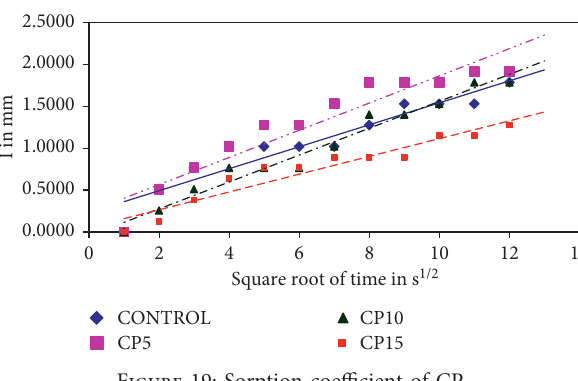
Figure 19: Sorption coefficient of CP.